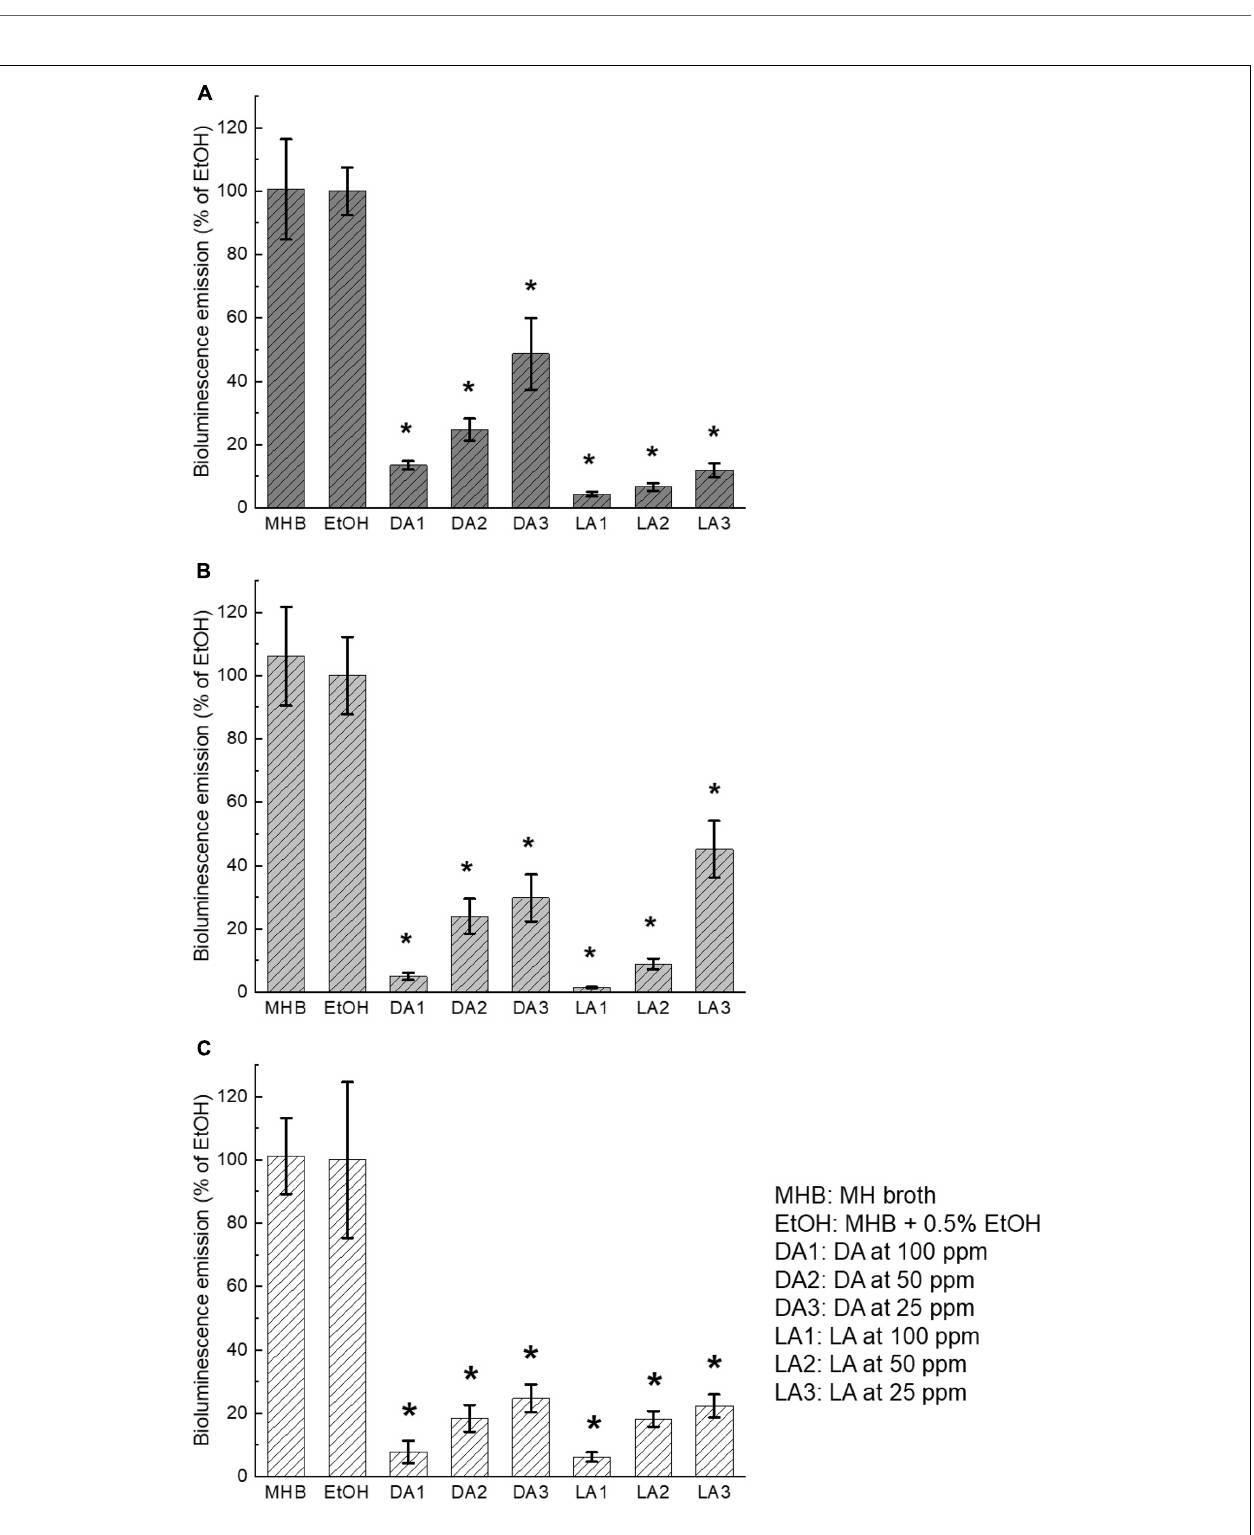
Frontiers in Microbiology |